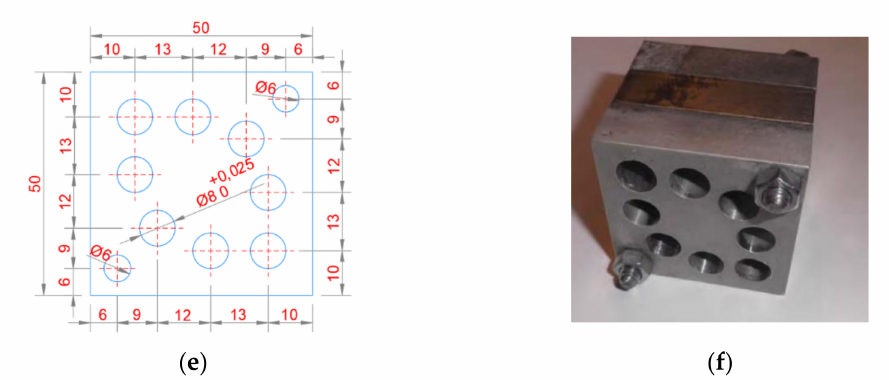
Figure 2. Main equipment, tools, and materials used during the trials. ( a ) Tongtai TMV510 machining